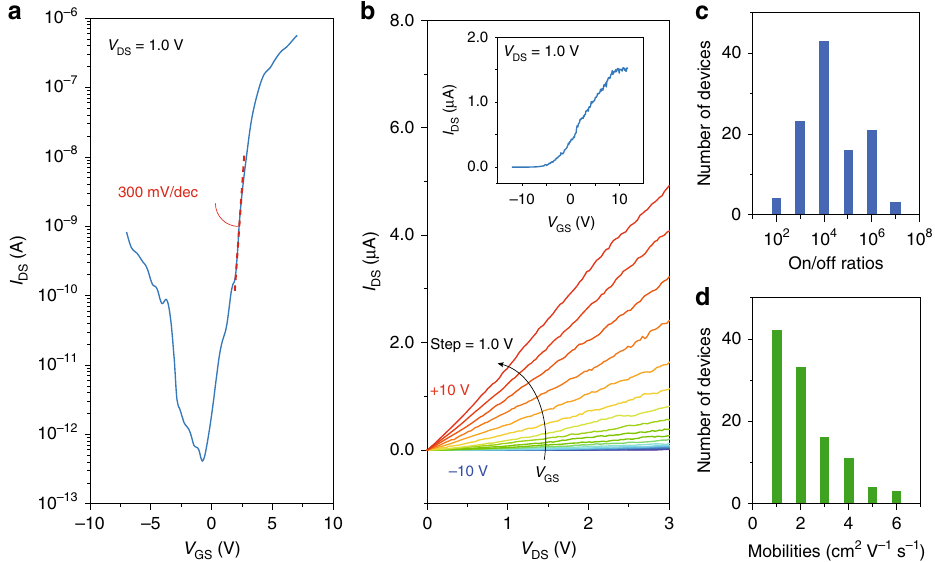
Fig. 3 Electrical performances of the MoS 2 ML-FinFETs. a Field effect curves at 1.0 V source-drain voltage of MoS 2 ML-FinFET. b I (cid:3) V curves at different gate voltages for the MoS ML-FinFET, the inset fi gure shows the fi eld effect curve of the same device. c , d Statistics of on/off ratios and mobilities of MoS 2 ML-FinFETs in this